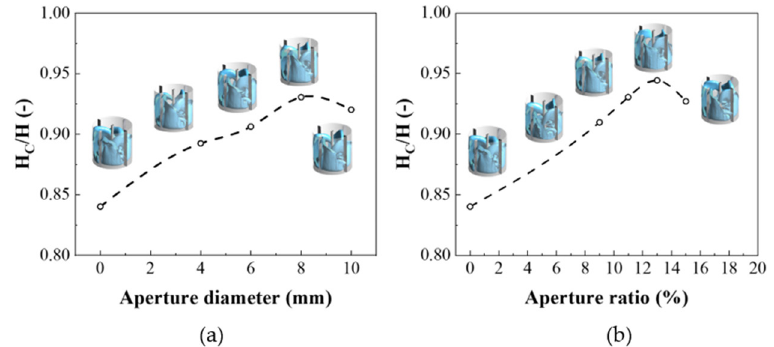
Figure 16. Influence of aperture parameters on cloud height. ( a ) Influence of aperture diameter, ( b ) influence of aperture ratio.